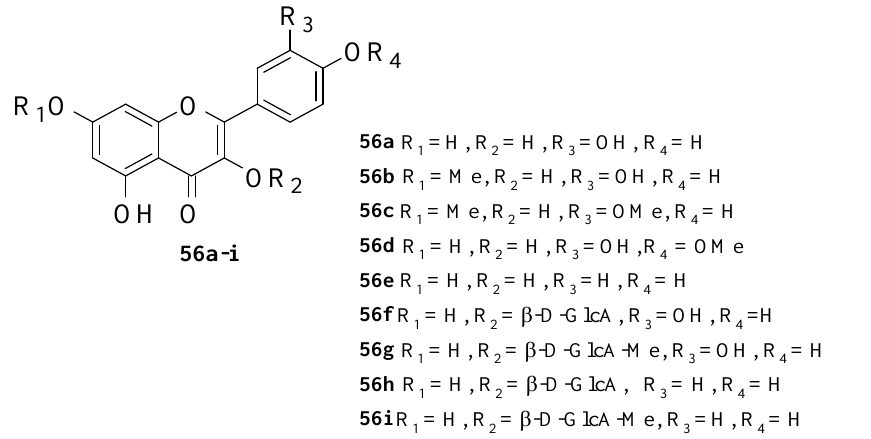
Figure 15. The structures of flavonoids isolated from T. gallica [52]. Da Silva et al. investigated the in vivo antidiabetic activity of kaempferol derivatives that were isolated from Sedum dendroideum leaf extract [53]. There were five derivatives tested in streptozotocin-induced diabetic mice for acute hypoglycaemic activity. The compounds tested are shown in Figure 16. It was reported that rhamnosyl units at positions 3 and 7 were responsible for the hypoglycaemic activity. In other words, a rhamnosyl unit at position C3 is important as it is present in kaempferitrin ( 57 ) but not in 58 and 59 , and the results showed 57 had higher hypoglycaemic activity compared to 58 and 50 . Next, to test the importance of the rhamnosyl unit at C7, 60 (with rhamnosyl unit at C7) and 61 (without rhamnosyl unit at C7) were tested. The results supported that a rhamnosyl unit at C7 is important as 60 exhibited hypoglycaemic activity after 120 min, but 61 showed activity after 60 min and lost activity at 120 min.